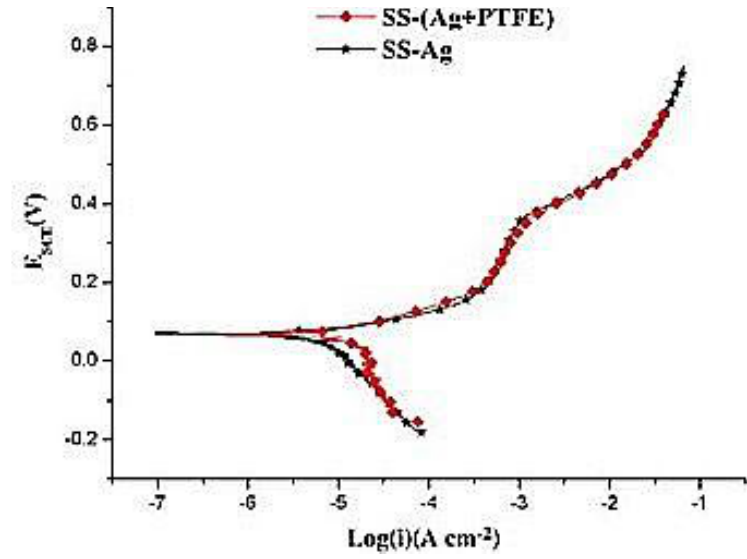
Figure 12. A potentiodynamic curves of Ag-PTFE and pure Ag [86].